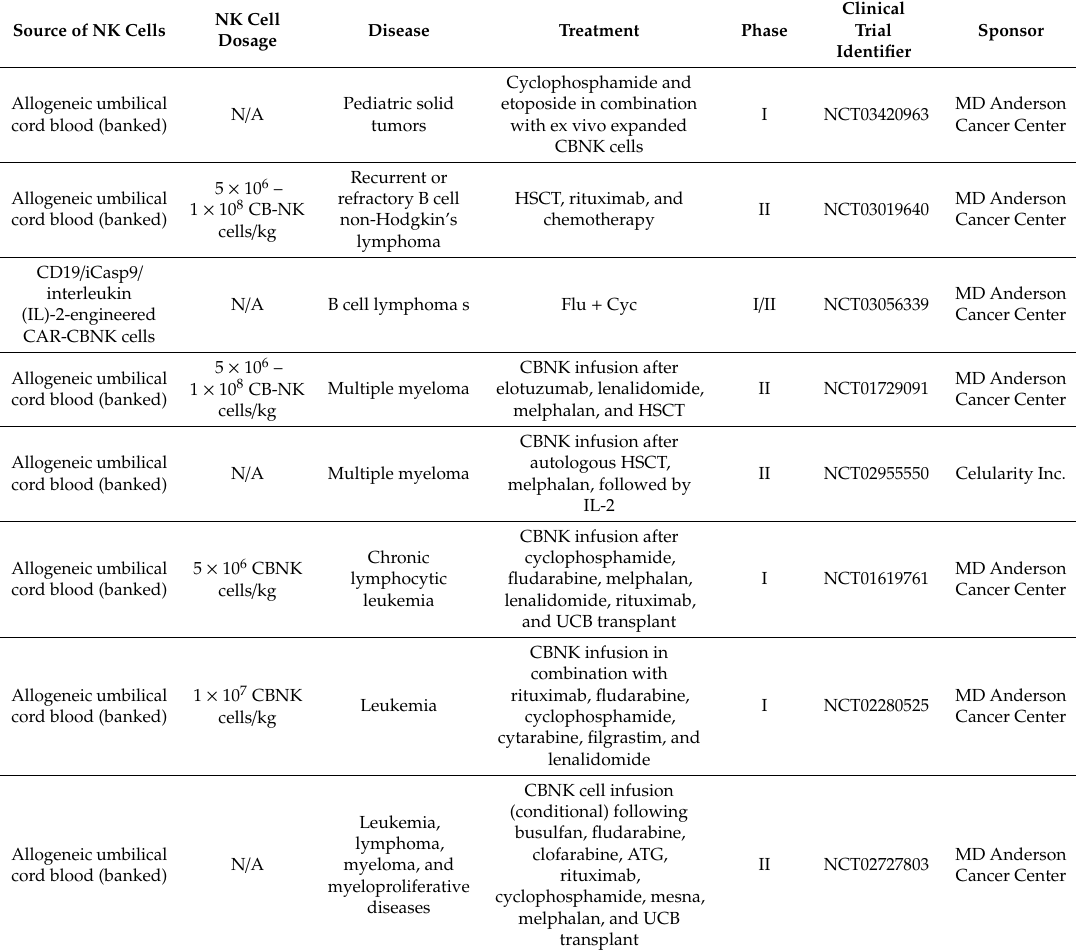
Table 3. Currently active and ongoing clinical trials with cord blood-derived NK